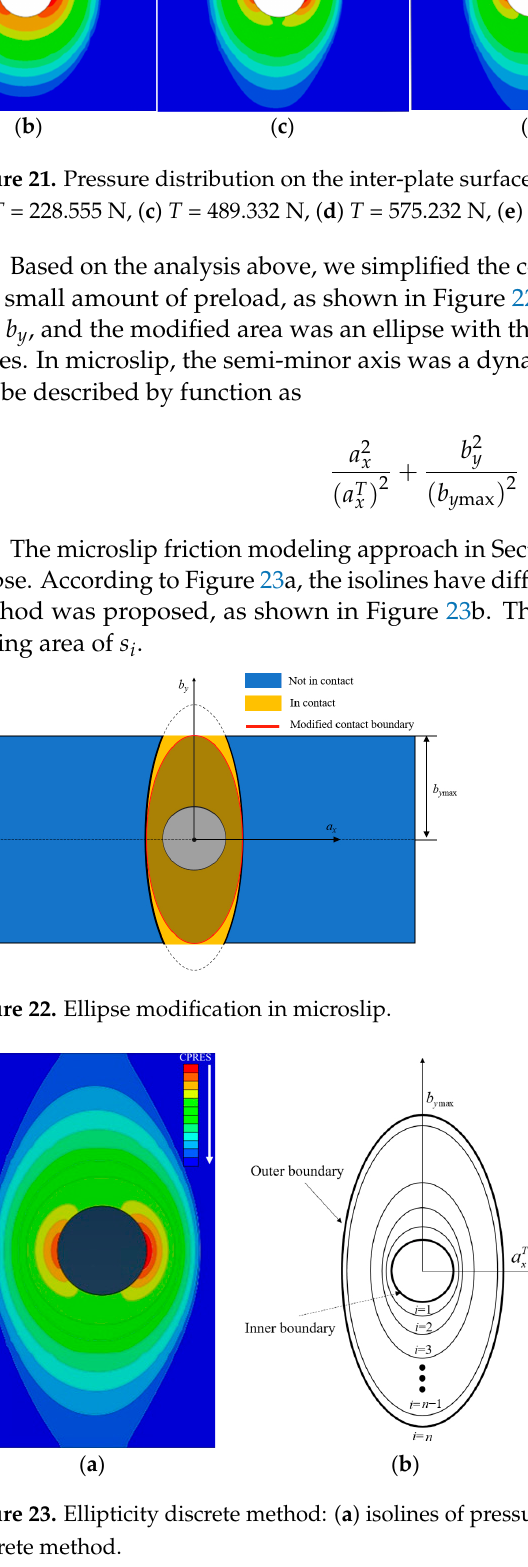
Figure 23. Ellipticity discrete method: ( a ) isolines of pressure on the inter-plate surface, ( b ) ellipticity discrete method. ′